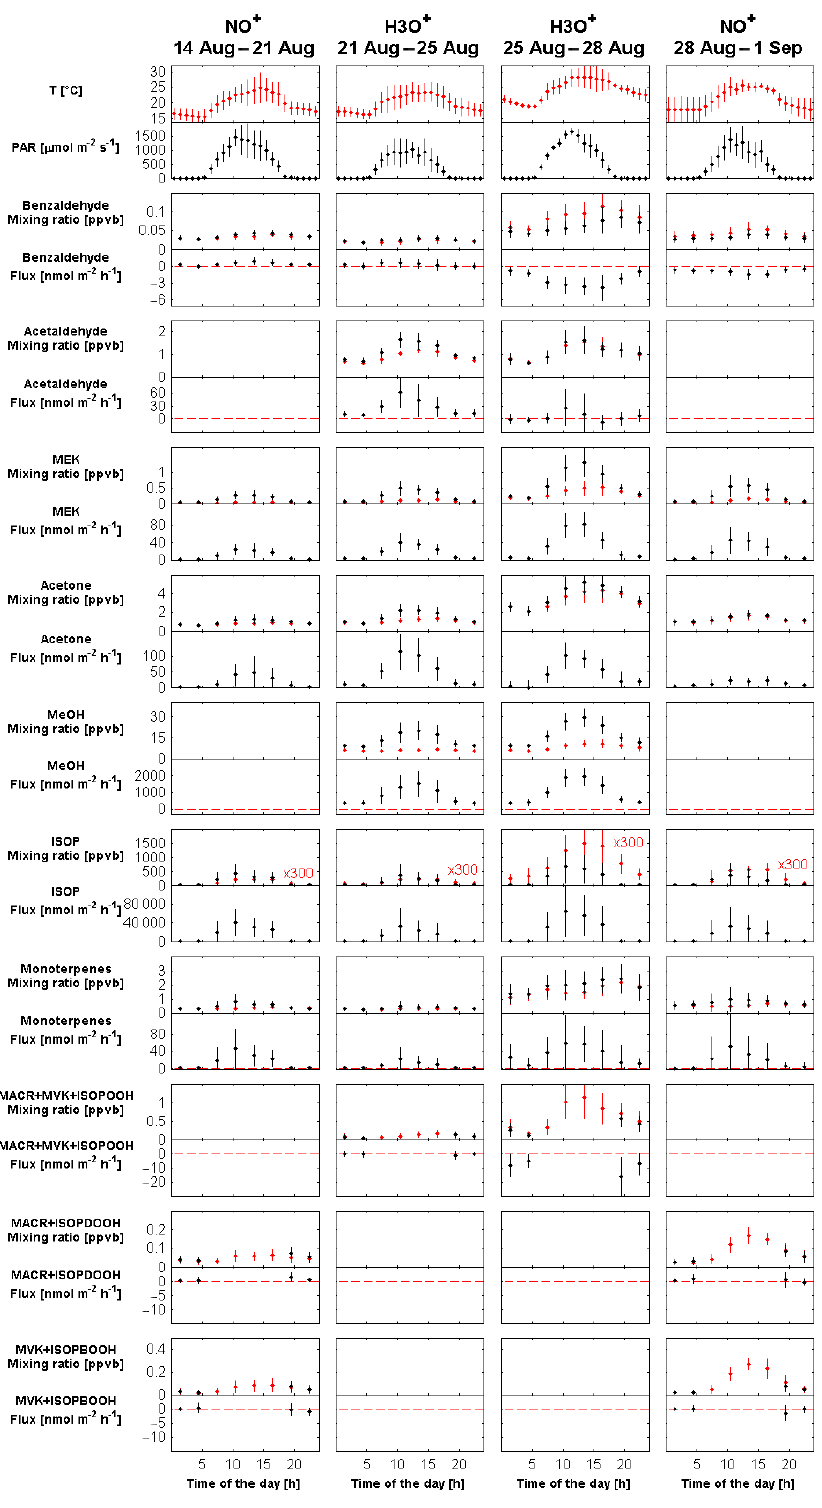
Figure 1. Diel average measured mixing ratios and fluxes in enclosures containing upper-canopy red oak branches at Harvard Forest. Mixing ratios of the inflow ambient air and of the outflow air are shown in red and black, respectively. Diel average temperature and PAR during the measurement period are also shown. Error bars represent standard errors of the data points in each time